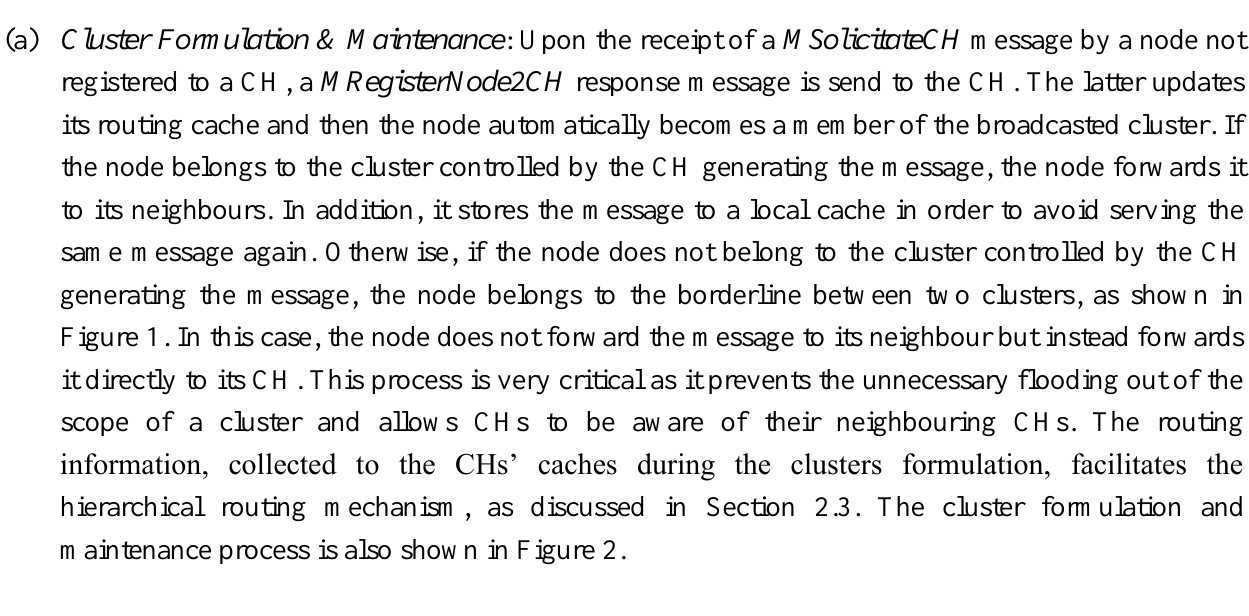
Figure 1. Controlled Flooding